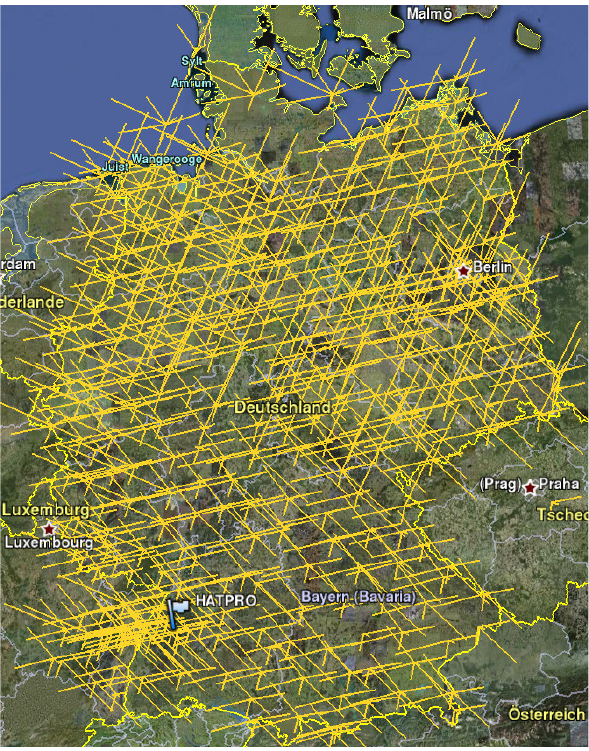
Fig. 3. Spatial coverage of the atmosphere by GPS slant paths in Germany. The flag shows the location of COPS investigation area. The sampling rate of STD is